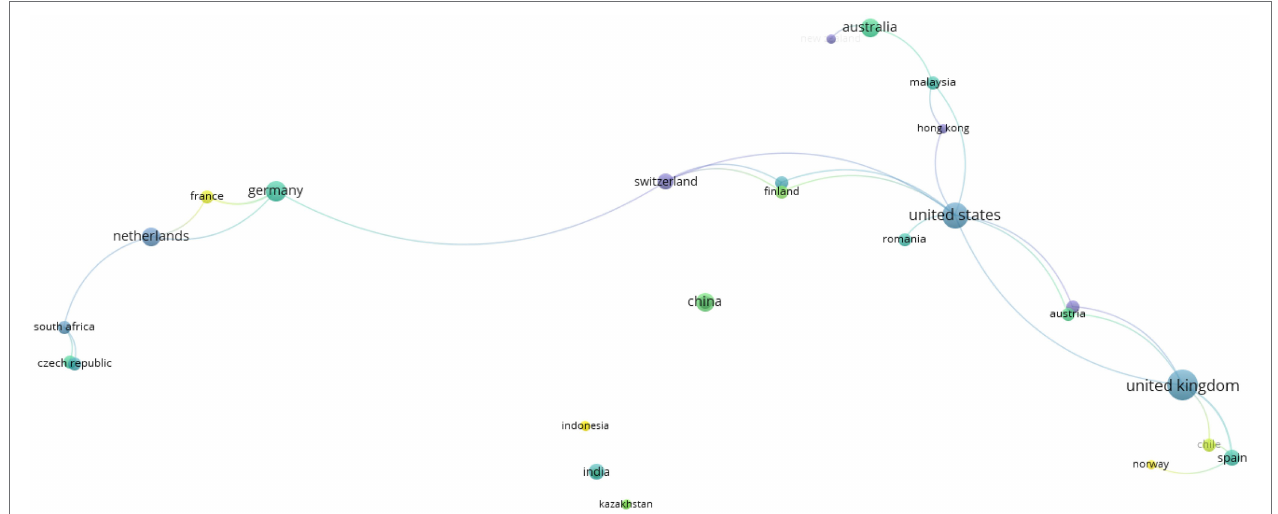
FIGURE 2 | Network of international collaboration in neuroentrepreneurship research.